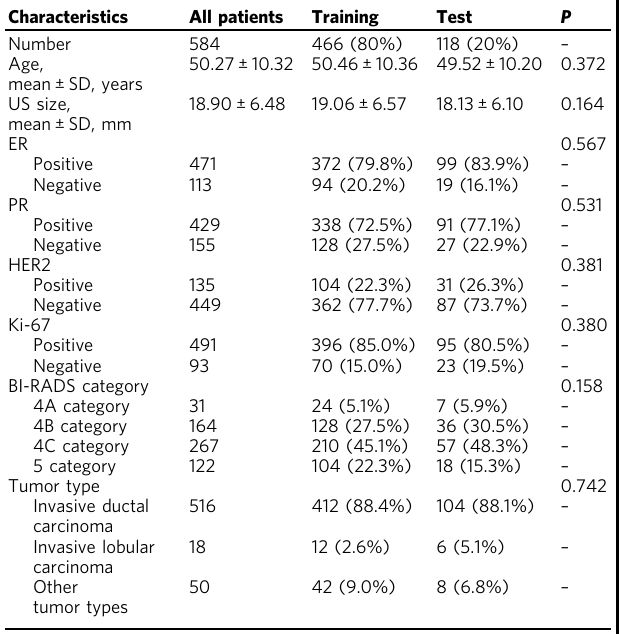
Table 2 Patient and tumor